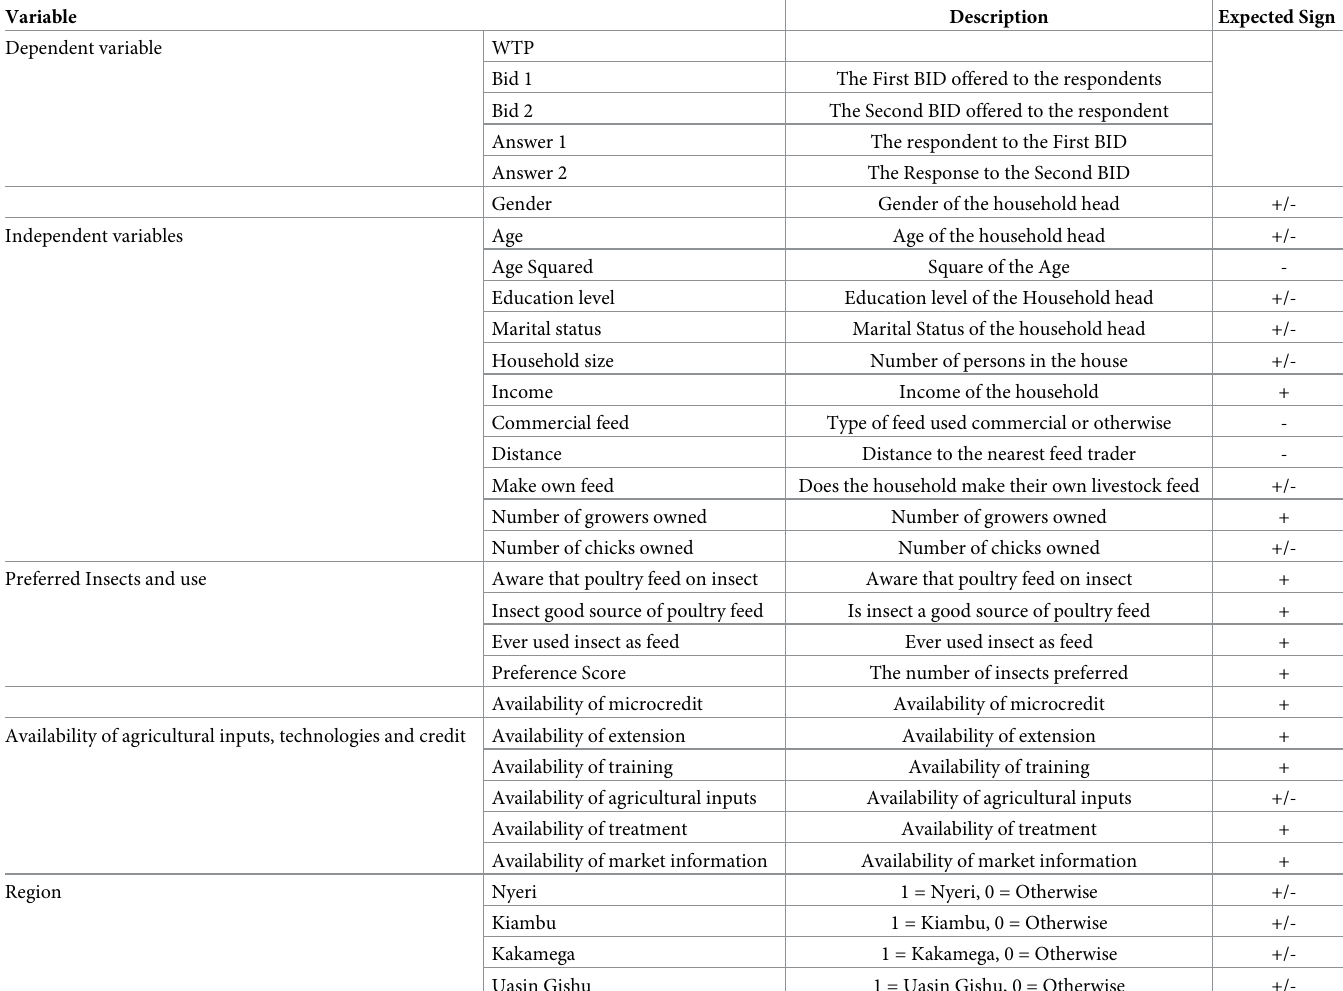
Table 1. Description of variables and their expected